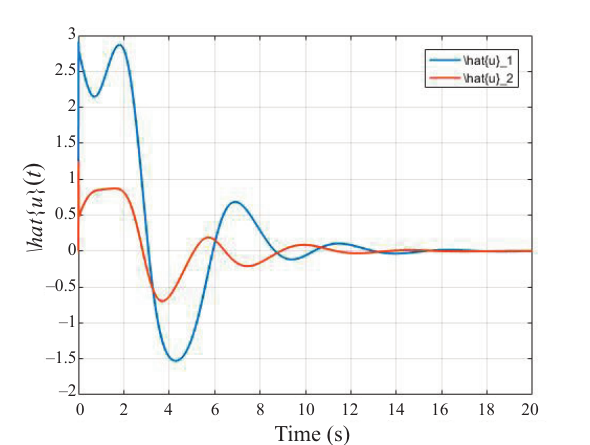
( t ) during tracking maneuver. r